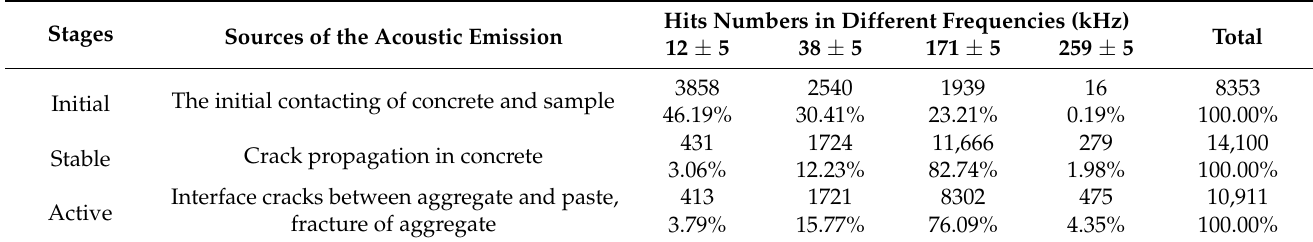
Table 2. Peak frequency—impacts count